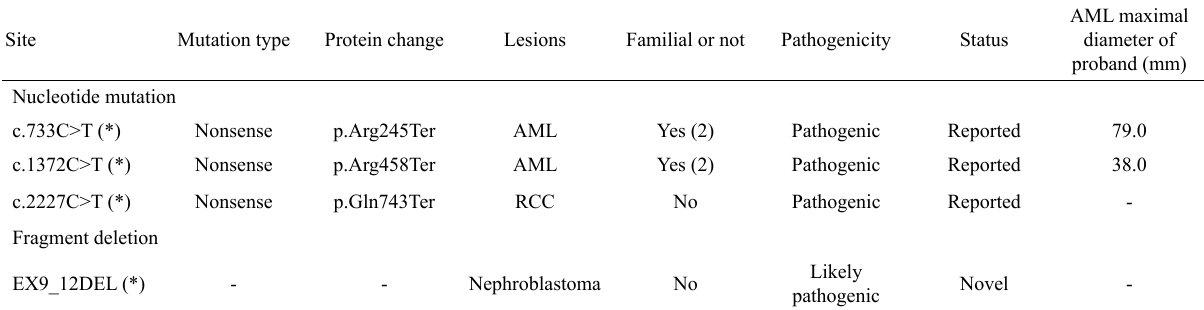
Table 3 - TSC1 gene mutation